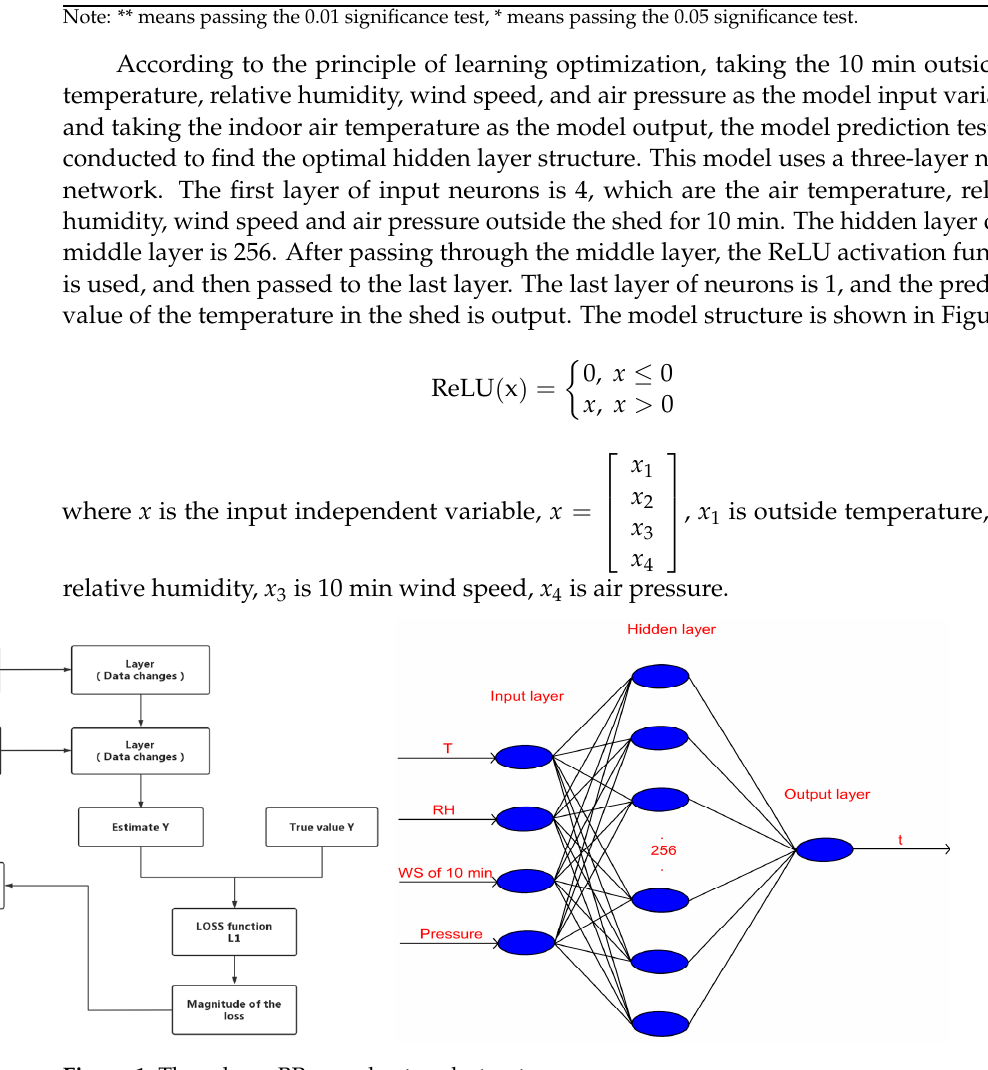
Figure 1. Three-layer BP neural network structure. The model uses the Adam optimizer, sets the learning rate to 0.001, uses the L1 loss function, the default number of each load is 3000, the default training is 50 rounds, and the model is saved after